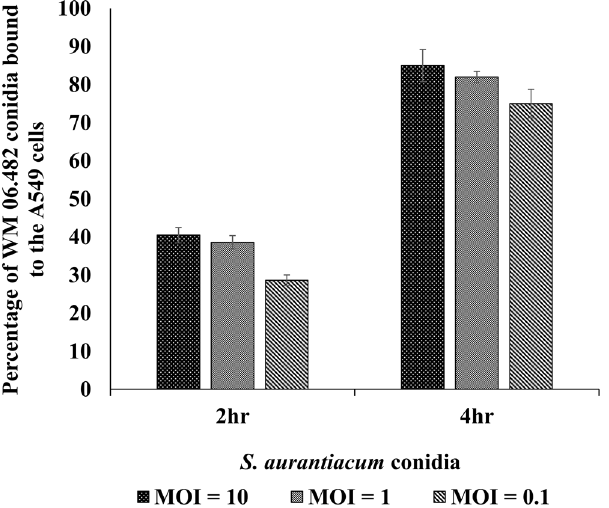
Figure 1. The extent of adhesion of S. aurantiacum WM 06.482 conidia to the A549 human lung epithelial cells after 2 h and 4 h, respectively. Error bars represent standard error ( ± SE) of the mean of three biological replicates for each time point. MOI = multiplicity of infection = number of